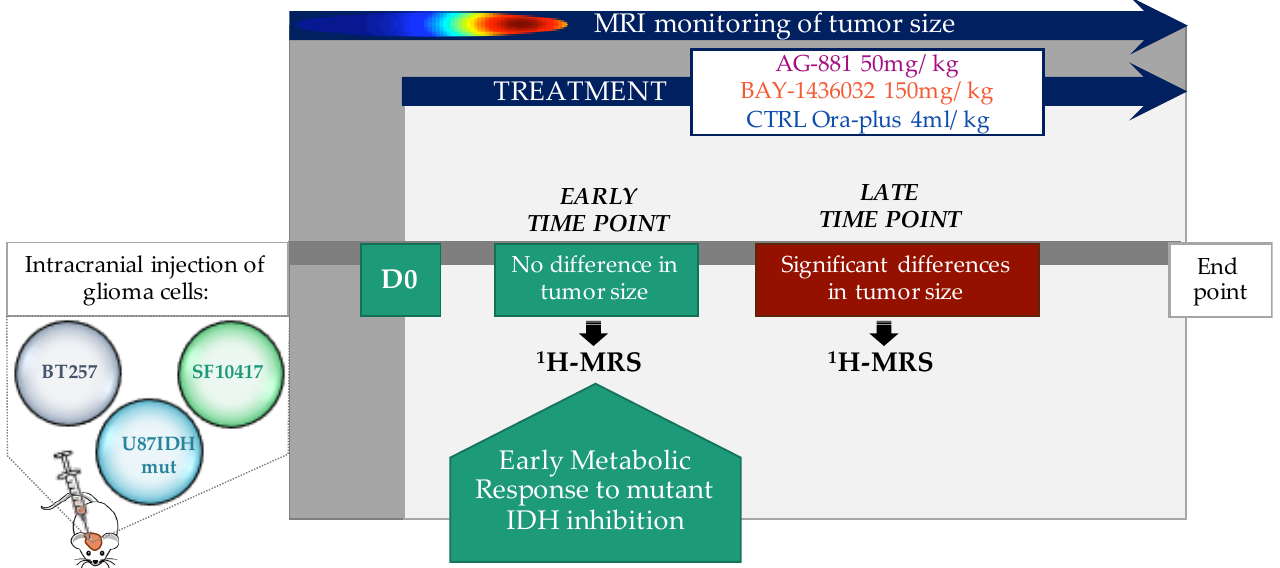
Figure 1. Schematic representation of in vivo 1 H-MRS study design for orthotopic glioma-bearing mouse models treated with mutant IDH inhibitors.